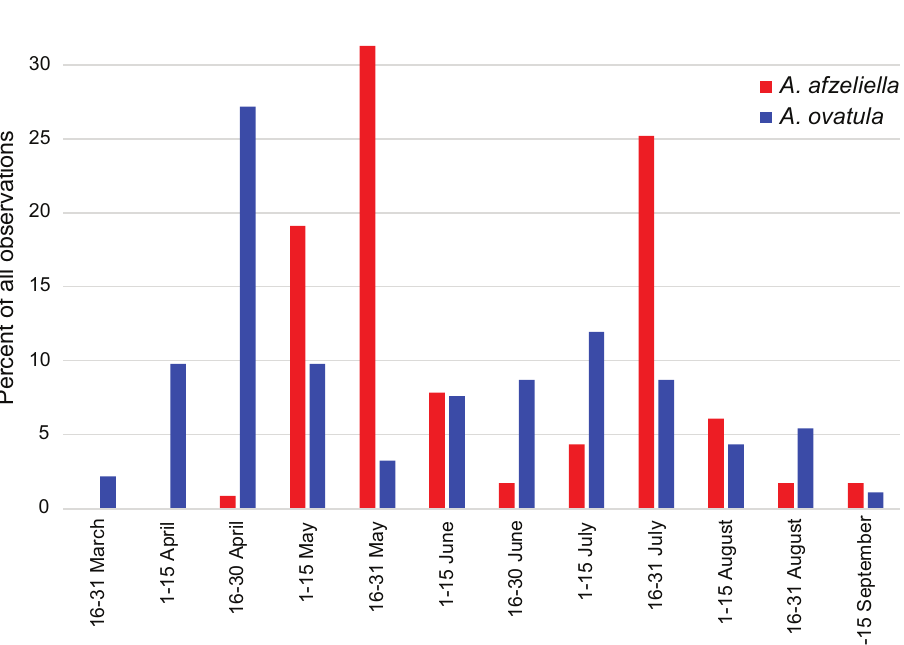
Figure 8. Phenology of Andrena ovatula (blue bars) and A. afzeliella (red bars) based on all examined specimens from Belgium, Netherlands and United